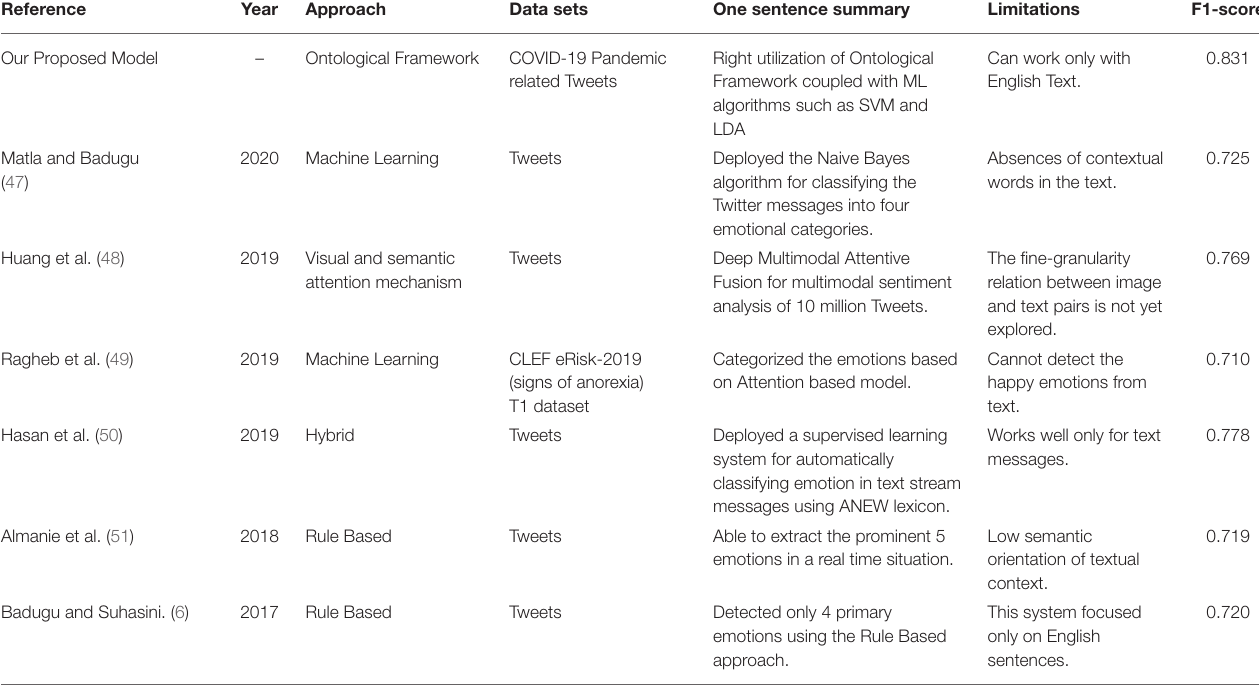
TABLE 7 | Comparative analysis with existing models and their